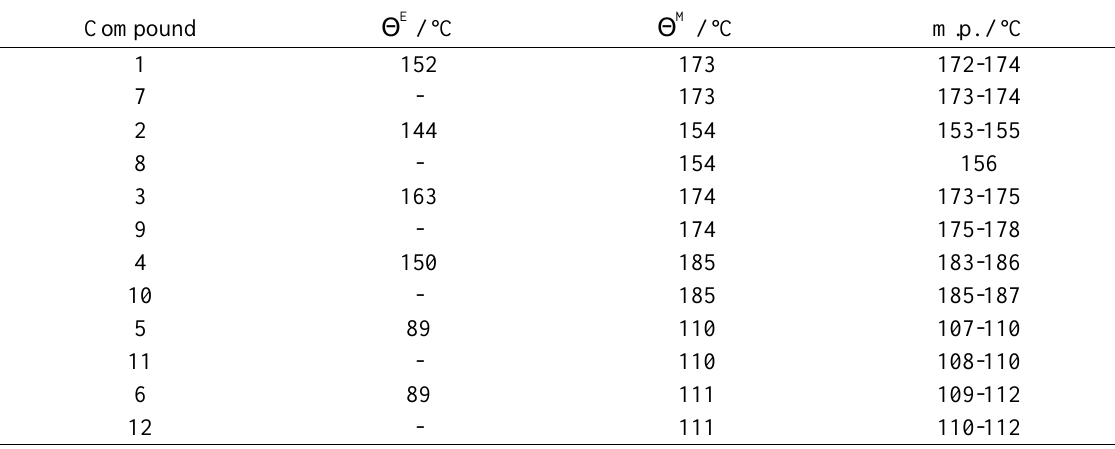
Table 4. T emperature values of exothermic Q E and endothermic Q M peaks of compounds 1-6 , 7-12 and their melting